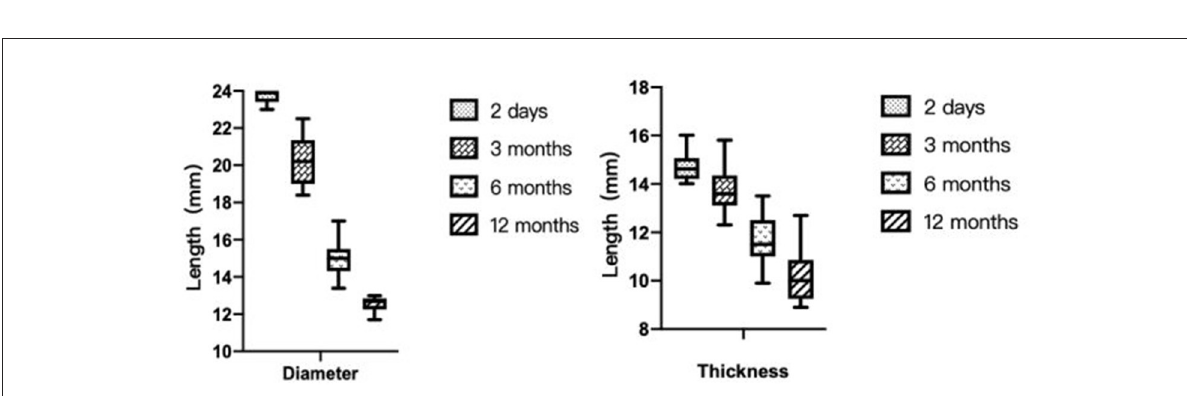
FIGURE4 The diameter and thickness change of the occluder after